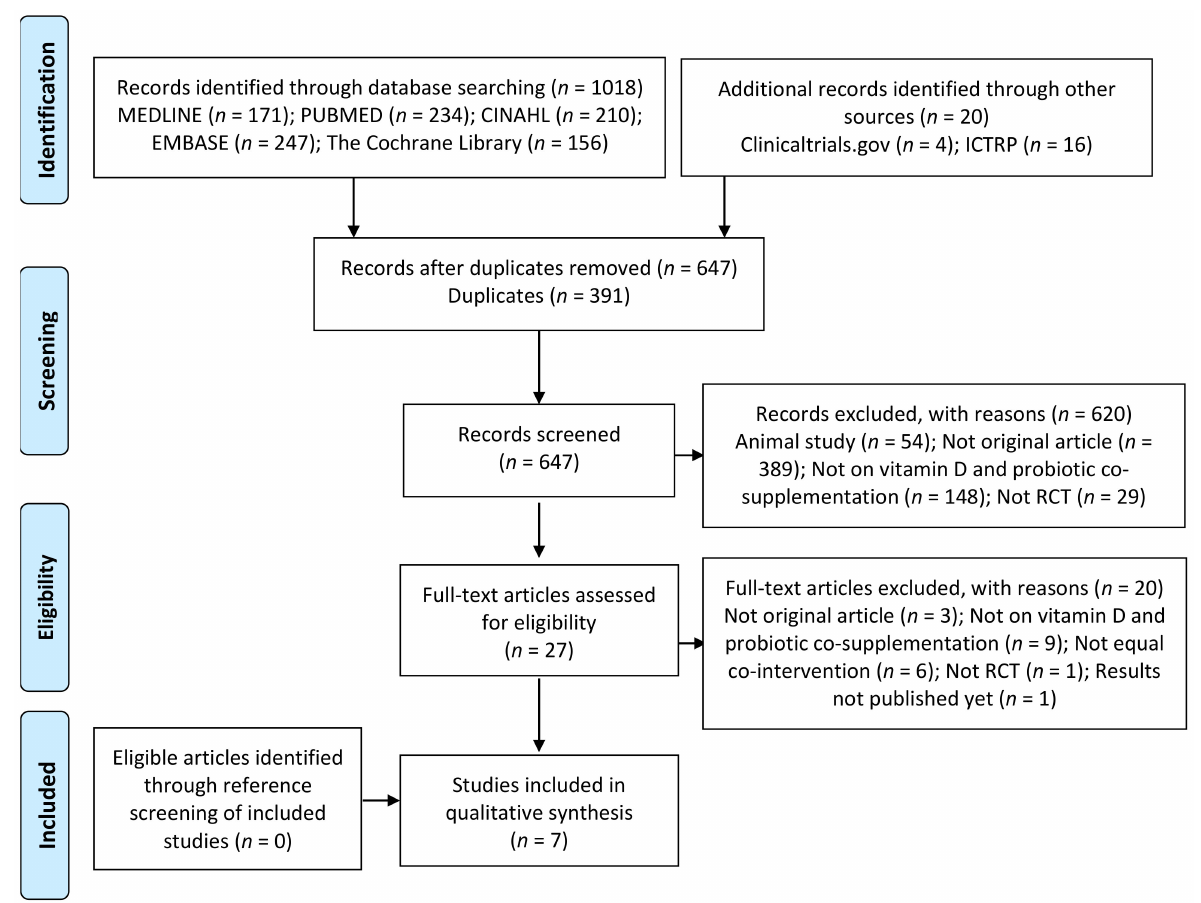
Figure 1. Preferred Reporting Items for Systematic Reviews and Meta-Analyses (PRISMA) Diagram of Study